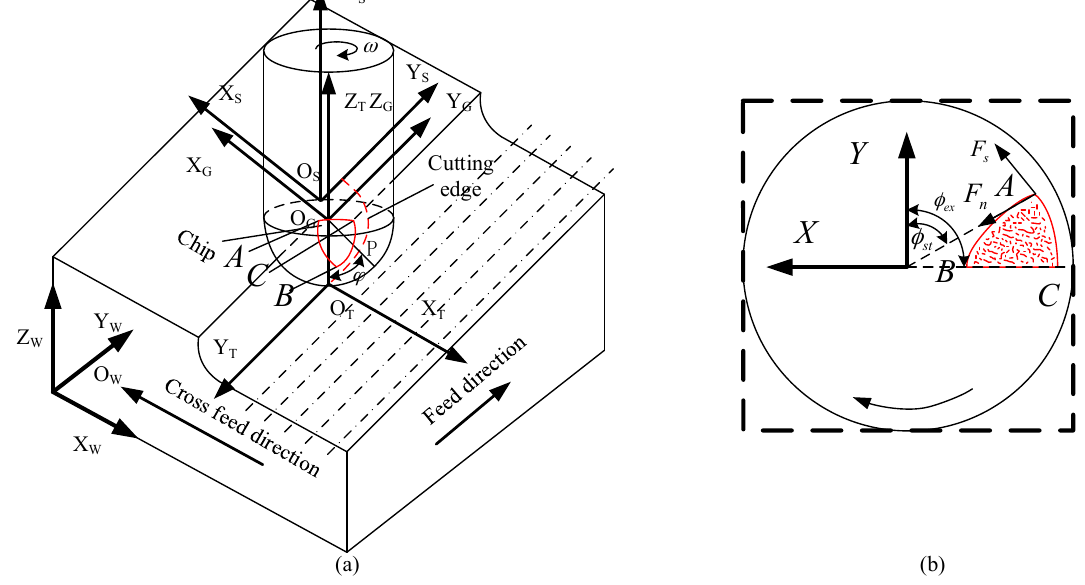
Figure 1. Reference coordinate system of the kinematic trajectory, ( a ) the cutter workpiece engagement; ( b ) the overhead view of the cutter workpiece engagement.